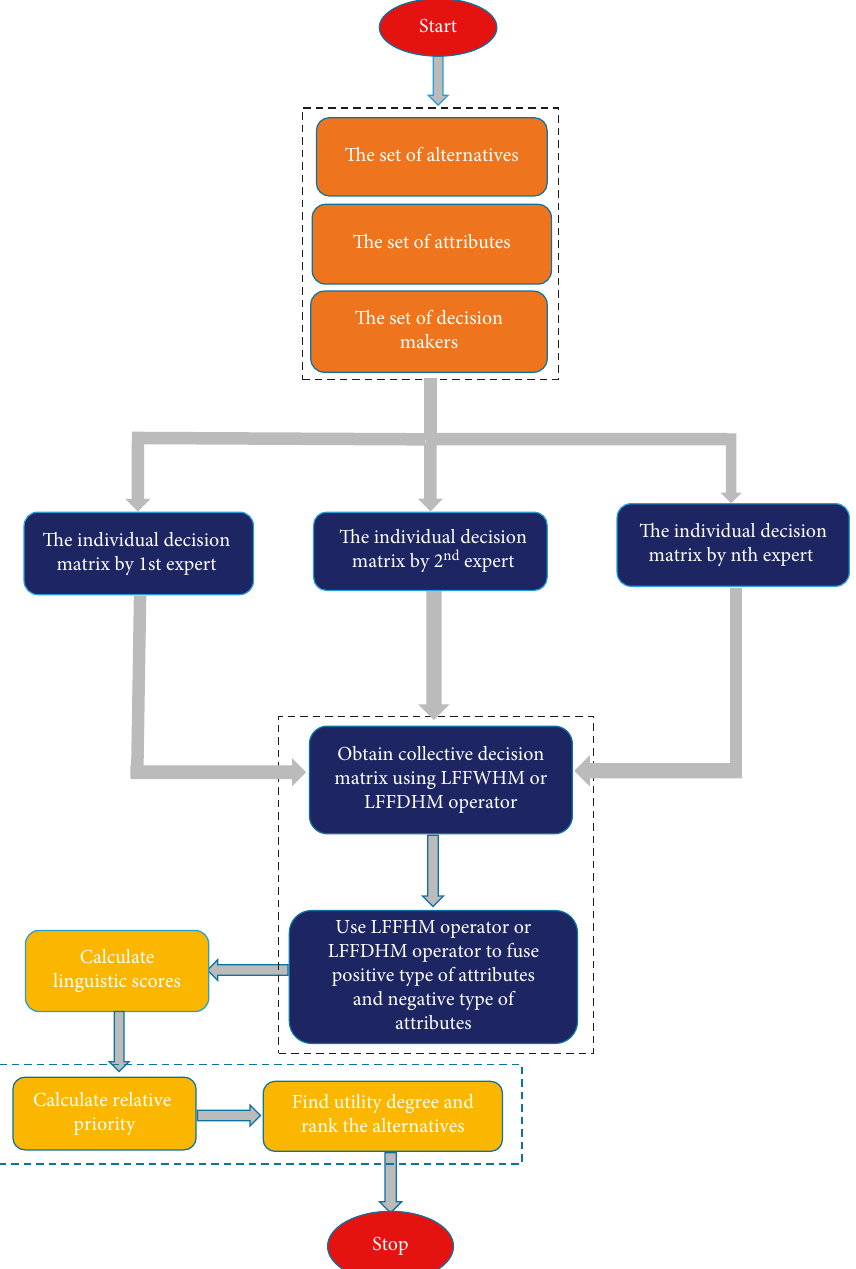
Figure 1: Flowchart of the linguistic Fermatean fuzzy COPRAS